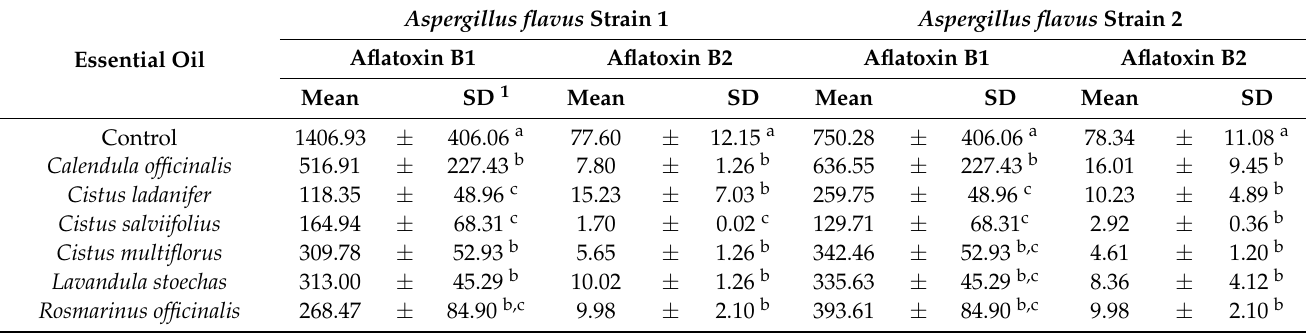
Table 5. Production of aflatoxins B 1 and B 2 (ppb) of Aspergillus flavus strains 1 and 2 determined in samples with different essential oils at the end of